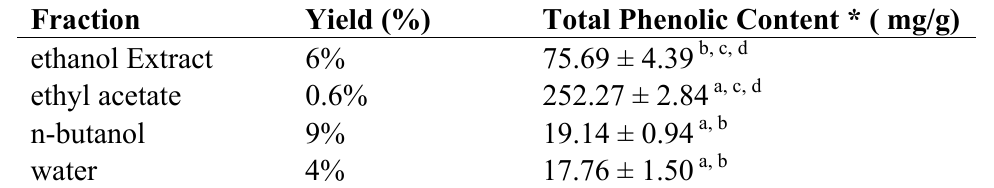
Table 3. Total phenolic content of ethanol extract and soluble fractions from Leptadenia pyrotechnica expressed as gallic acid equivalents (mg/g of dry extract).